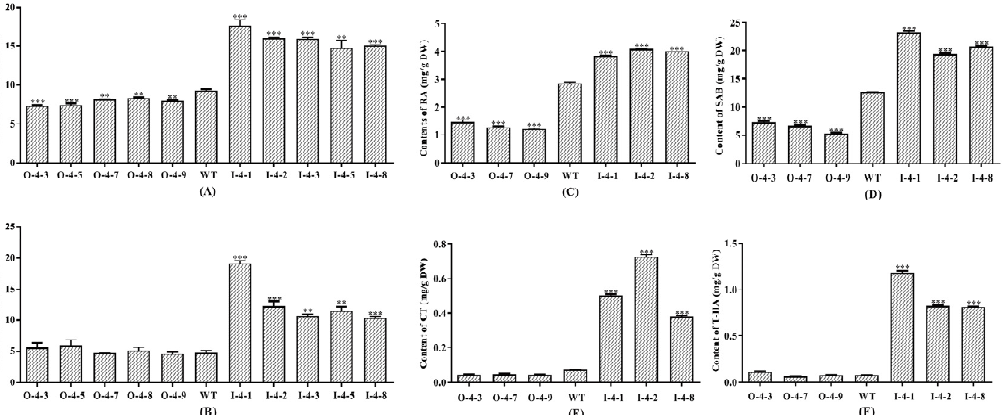
Figure 4. The content of metabolites in the transgenic plants. ( A – F ) indicate the content of the total phenolic acids, total flavonoids, RA, SAB, CT, and T- Ⅱ A, respectively (** p < 0.01, *** p < 0.001).